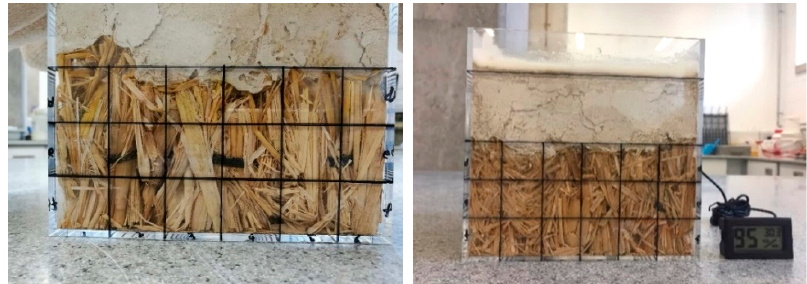
Figure 8. Specimen of rice straw with perpendicular placing before the degradation research ( left ) and after 12 weeks in climatic chamber ( right ).